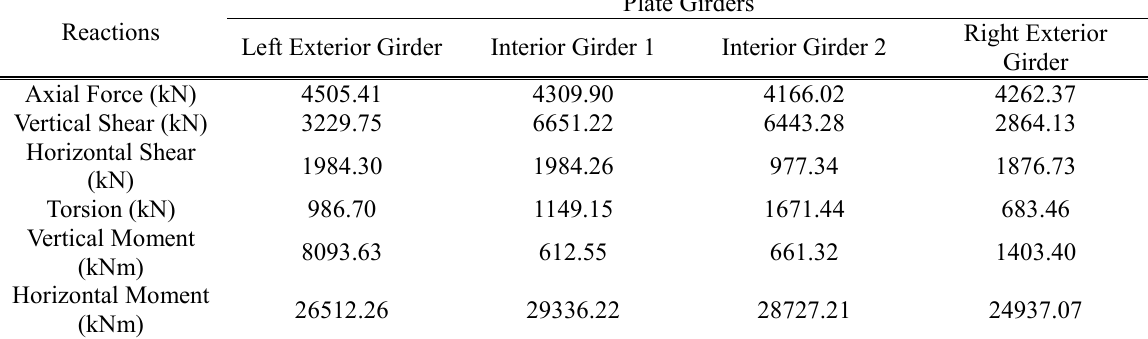
Reactions from the Plate Girders due to ULS load